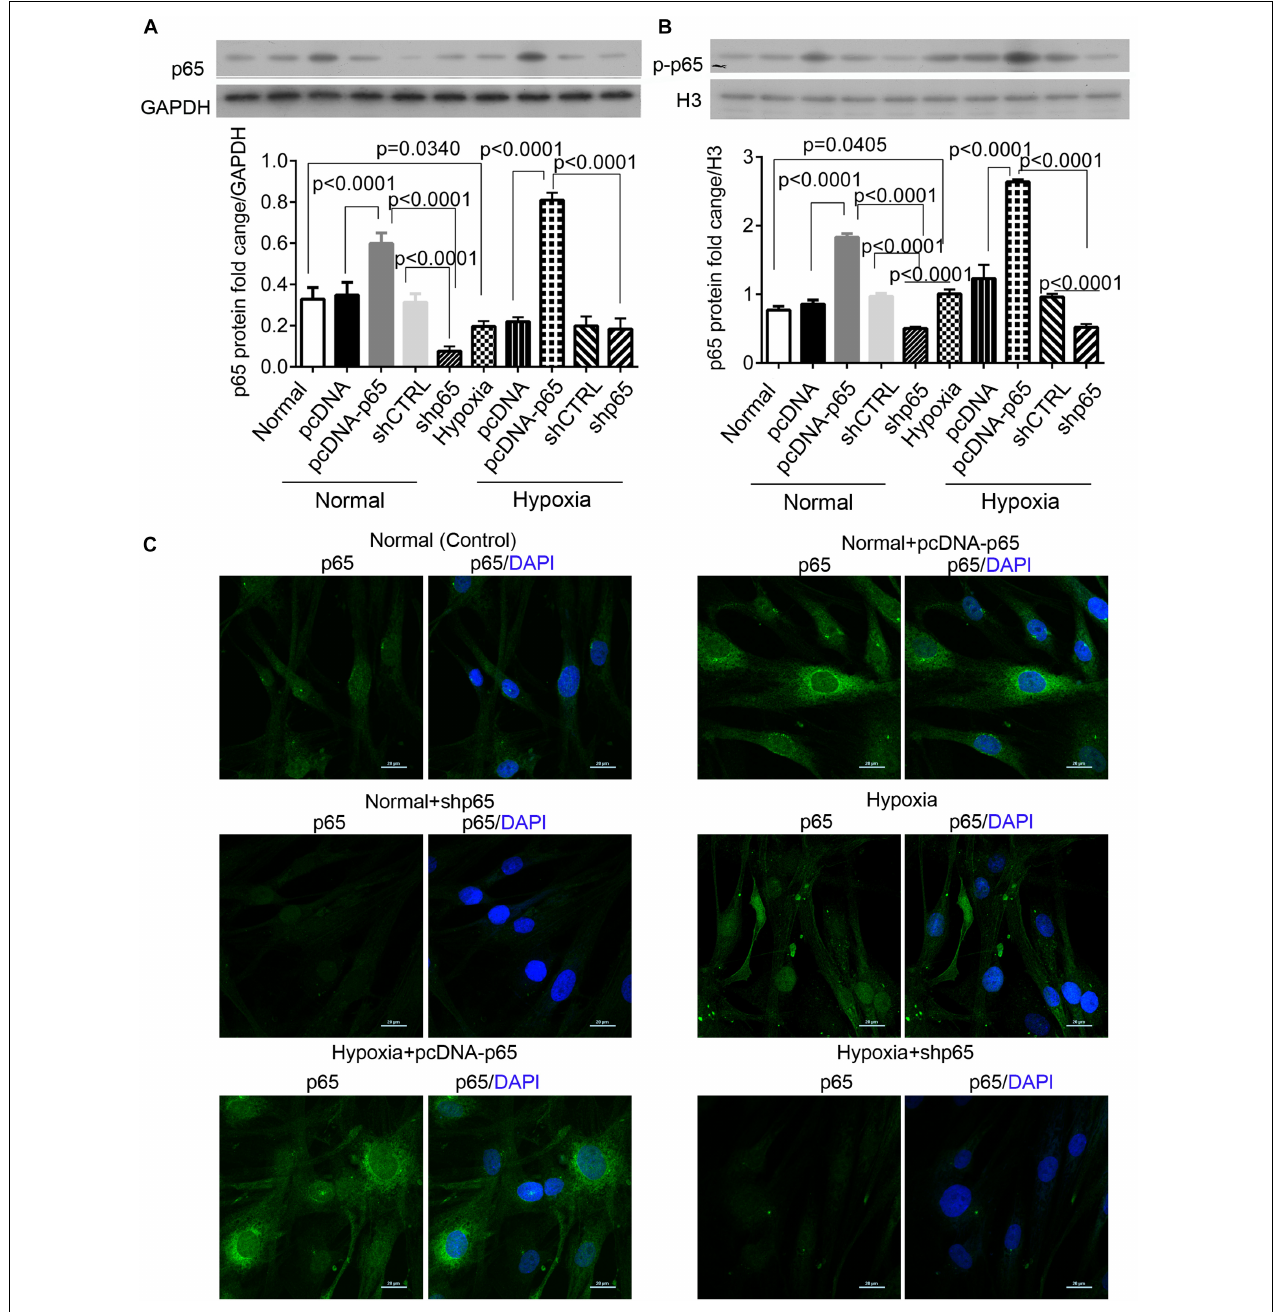
FIGURE 1 | The expression of cytoplasmic and nuclear p65 proteins in response to hypoxia. (A,B) The expression levels of the cytoplasmic and nuclear p65 proteins in the hPASMCs upon hypoxia treatment (72 h) with and without the transfections of pcDNA-p65 and shp65. Each experiment was repeated three times. The differences were analyzed using one-way ANOVA. CTRL, control. (C) The immunofluorescence assay of the cytoplasmic p65 protein in the hPASMCs upon the above